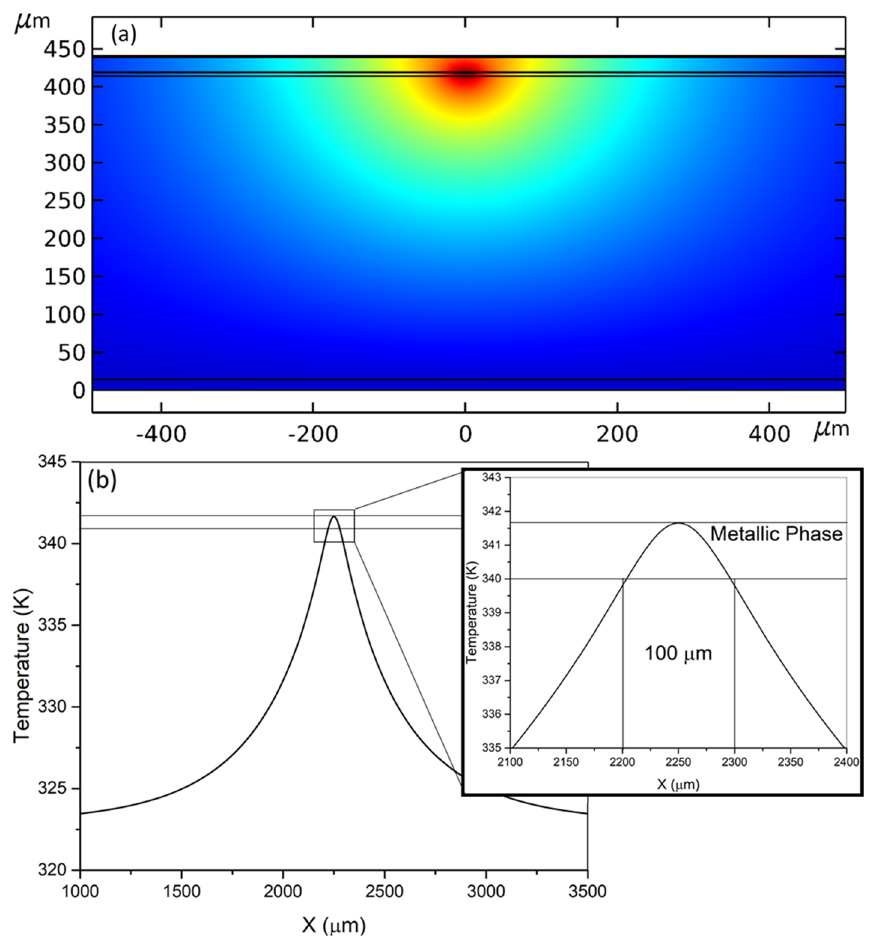
Figure 2. ( a ) 2D view of the thermal simulation of the device structure in Fig. 1b, which shows the thermal distribution of a single heater cell turned on. ( b ) Temperature curve of the top surface of the VO 2 layer with a single heater on, with an inset showing the 100 μm